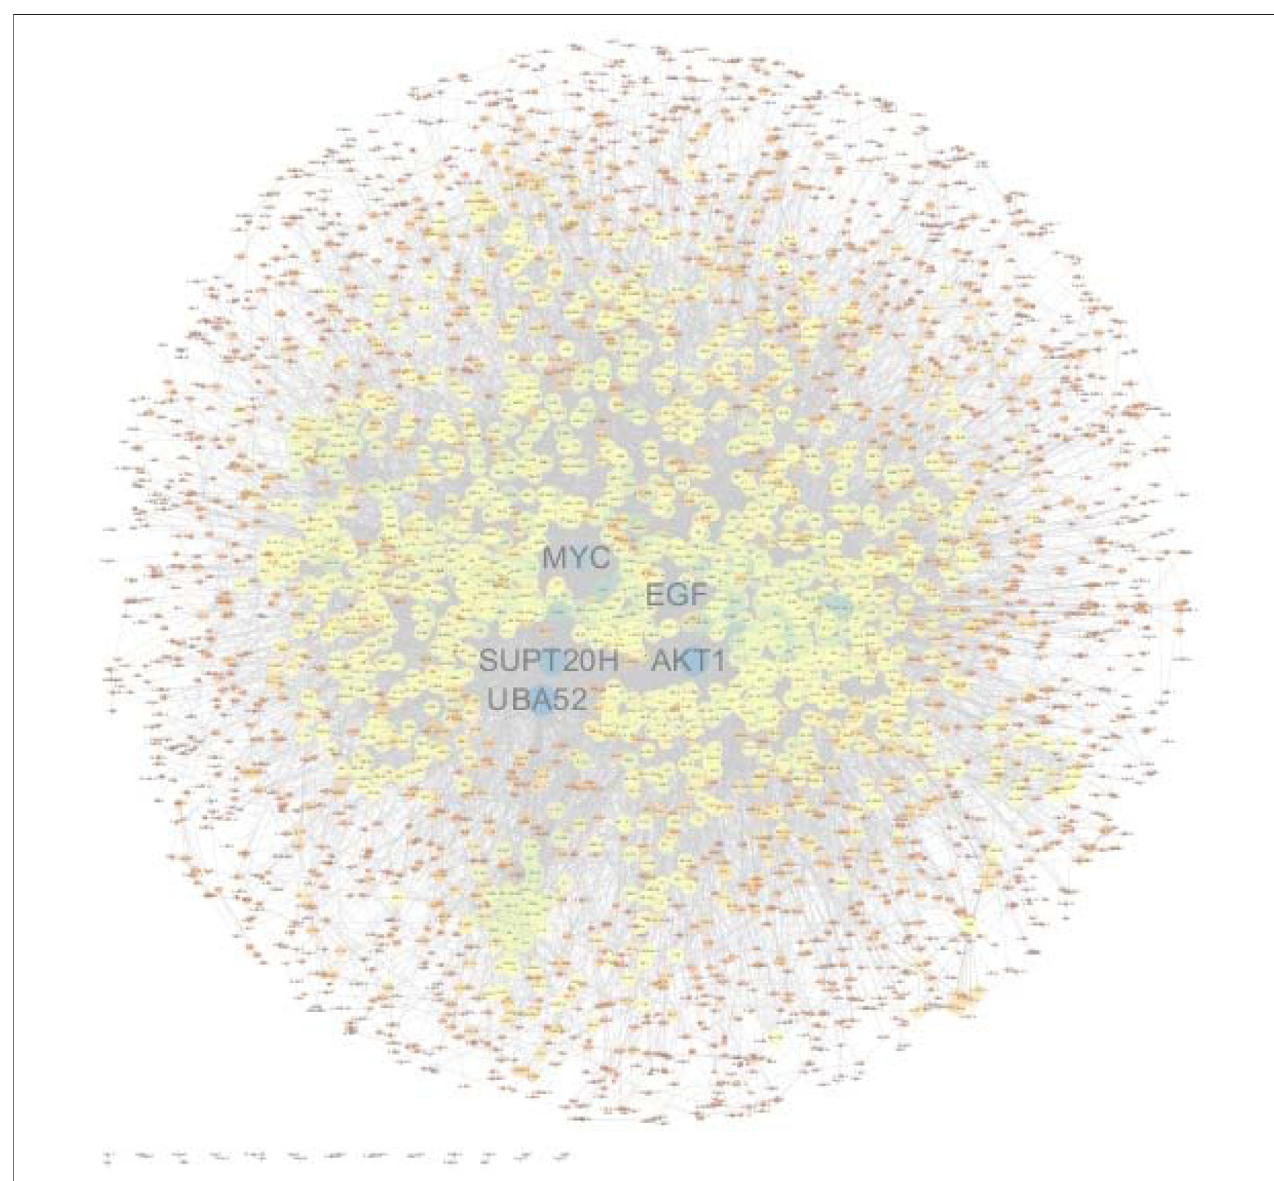
FIGURE 9 | Protein – protein interaction network of signi fi cant differentially expressed genes. PPI nodes with relatively high connectivity include UBA52 , AKT1 , SUPT20H , RPL19 , EGF , and MYC . The size of a node in a PPI map is proportional to the degree of the node.